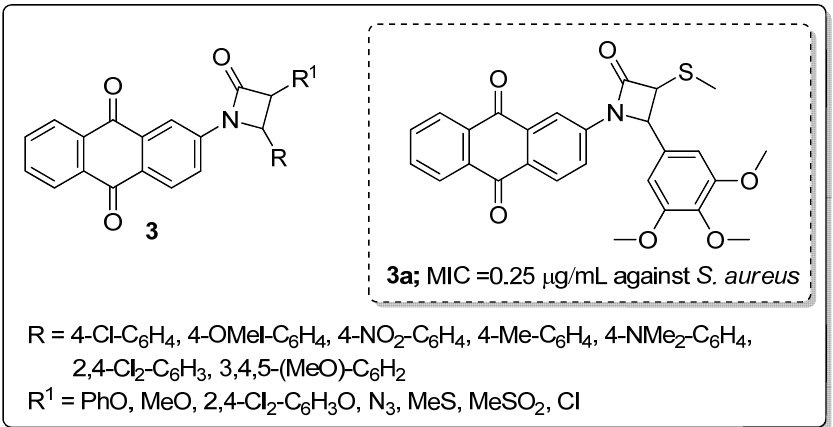
Figure 5. Most potent antibacterial β -lactam-anthraquinone hybrid 3a .